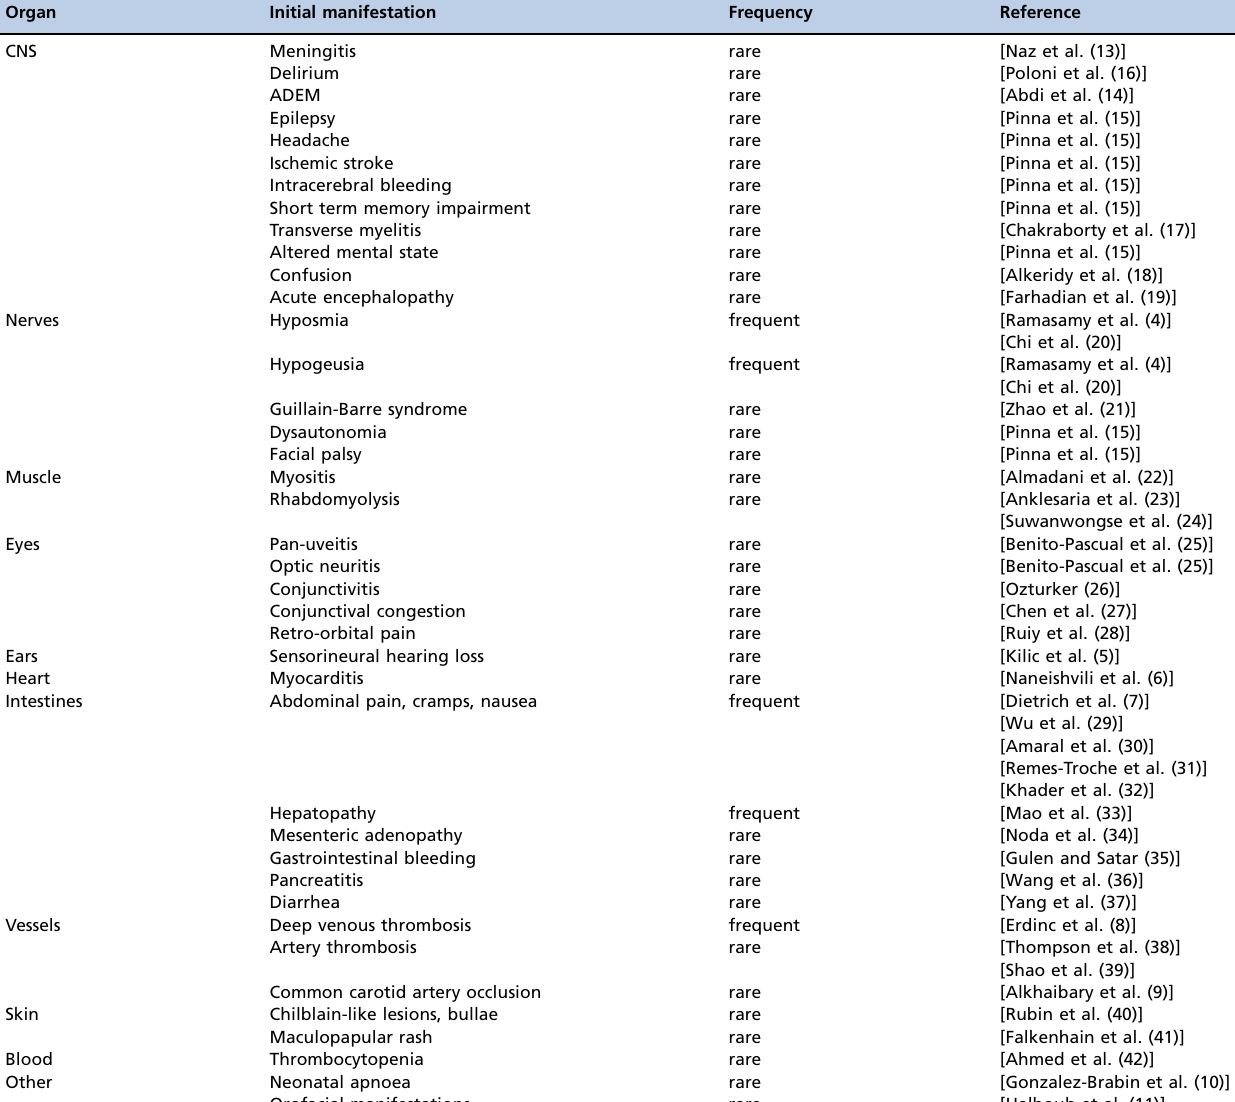
Table 1 - Overview of the initial clinical manifestations of SARS-CoV-2-infected patients.